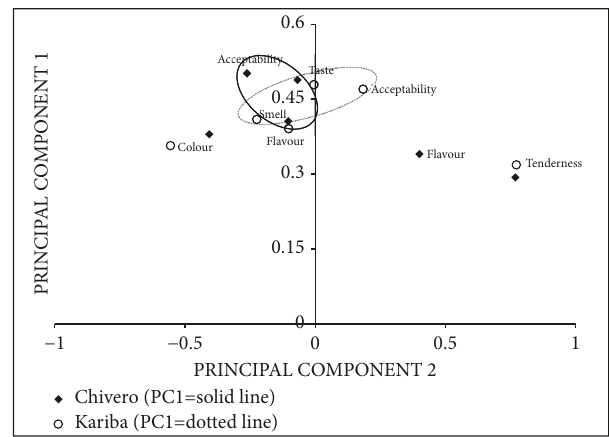
Figure 2: Component patterns for PC1 and PC2 for fish from Lake Kariba and Lake Chivero.